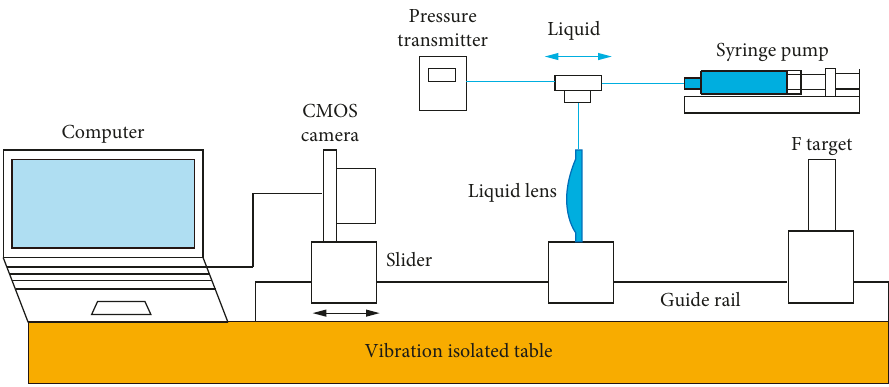
Figure 6: Schematic of the optical experiment setup used for image acquisition.